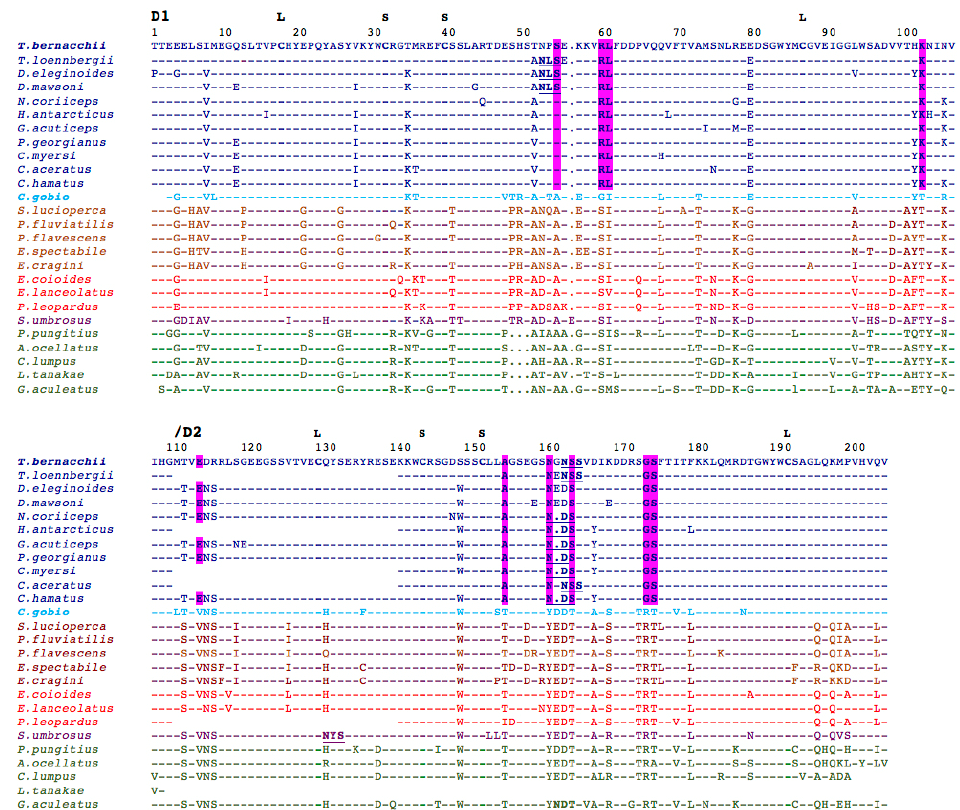
Figure 8. Multiple amino acid sequence alignments of pIgR D1–D2 domains from Notothenioidei (in blue; T. bernacchii in bold blue, and C. gobio in bold light blue) and other species of the perciform suborders Percoidei (in brown), Serranoidei (in red), Scorpaenoidei (in purple), and Cottoidei (in green). Antarctic-notothenioid-specific residues are reported in bold and highlighted in magenta. The highly conserved cysteine residues, characteristic of the immunoglobulin fold, are in bold. The large (L) and the small (S) loops are indicated above the cysteine residues forming them. Putative N-glycosylation sites are in bold and underlined. Amino acid residues that are identical to those shown in the sequence of T. bernacchii are indicated by dashes. Gaps are indicated by dots. The complete alignment is shown in Figure S3.